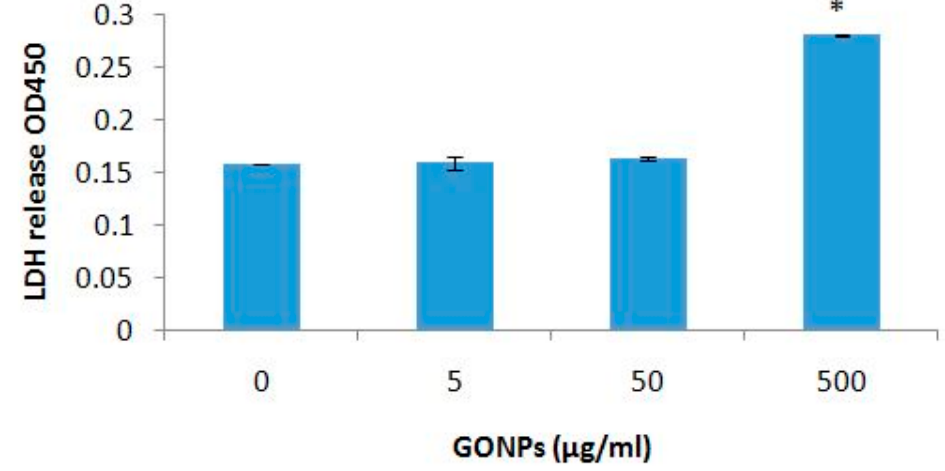
Figure 4. Cell viability of whole blood cell cultures exposed to GONPs. Data represents mean ± SD with n = 4. Bars marked with symbol indicate significant difference to control ( p < 0.01). Significance demarcated by: *—significantly different compared to negative control ( p < 0.003).